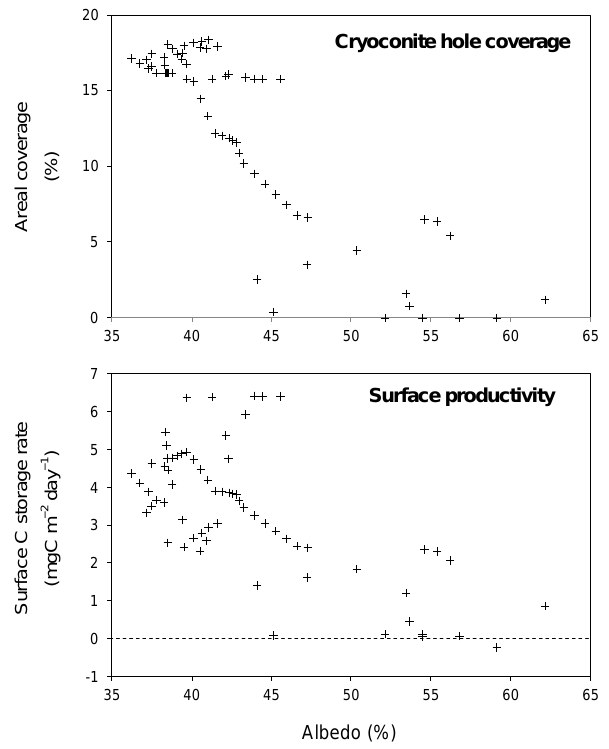
Figure 15. Correlations between albedo and cryoconite hole cov- erage (top) and between albedo and surface productivity (bottom). Each point is a daily value, linearly interpolated from the respective time series since observations of each quantity were generally not made